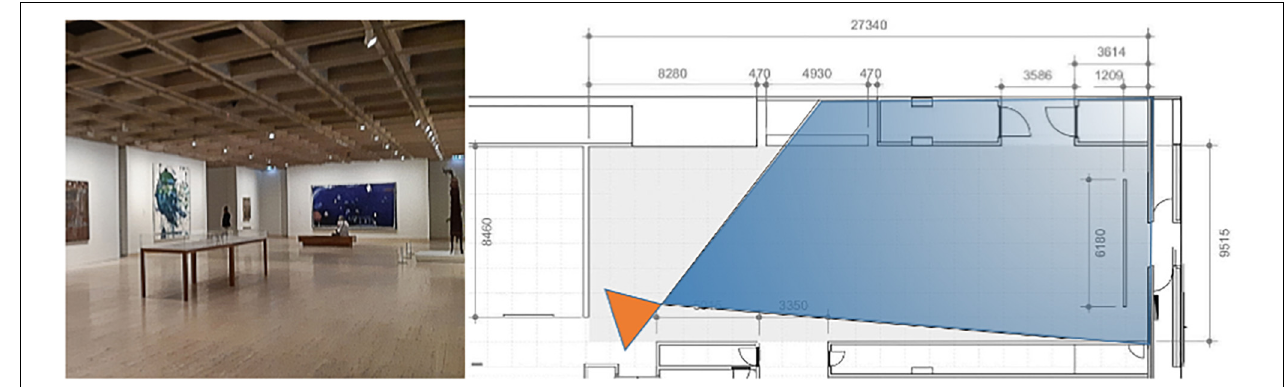
FIGURE 3 | The 20th Century Australian Art room at the Art Gallery of New South Wales: (top) photograph; plan indicating the field of the view of the photograph. Adapted from a plan supplied by AGNSW.